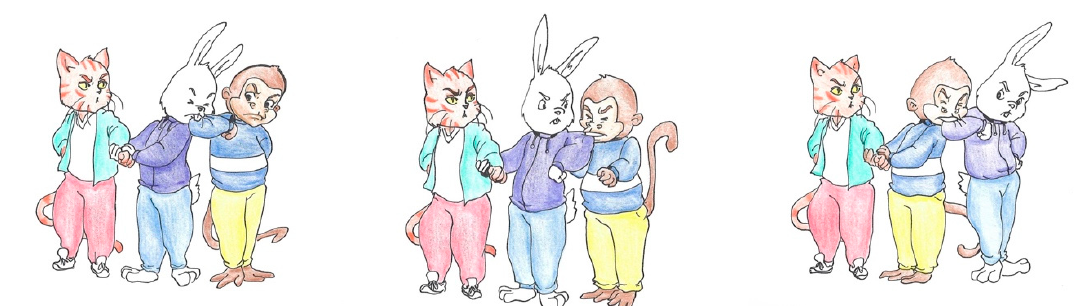
Figure A8. SRC stimulus 3.